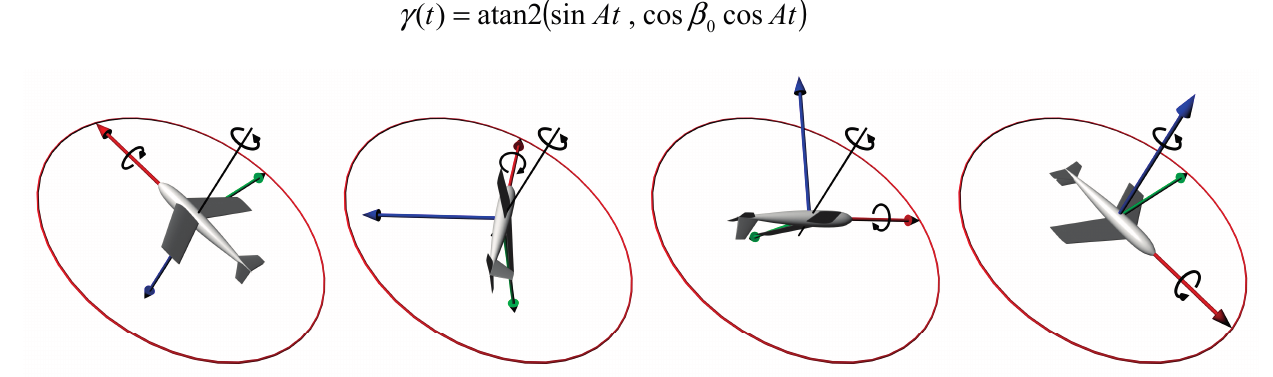
Figure 4. Half turn of the simulated precession movement.